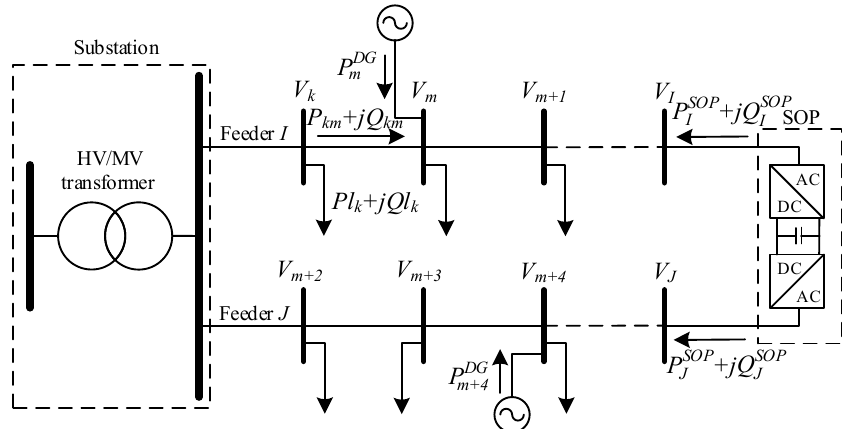
Figure 1. Medium-voltage DN with a SOP connected.